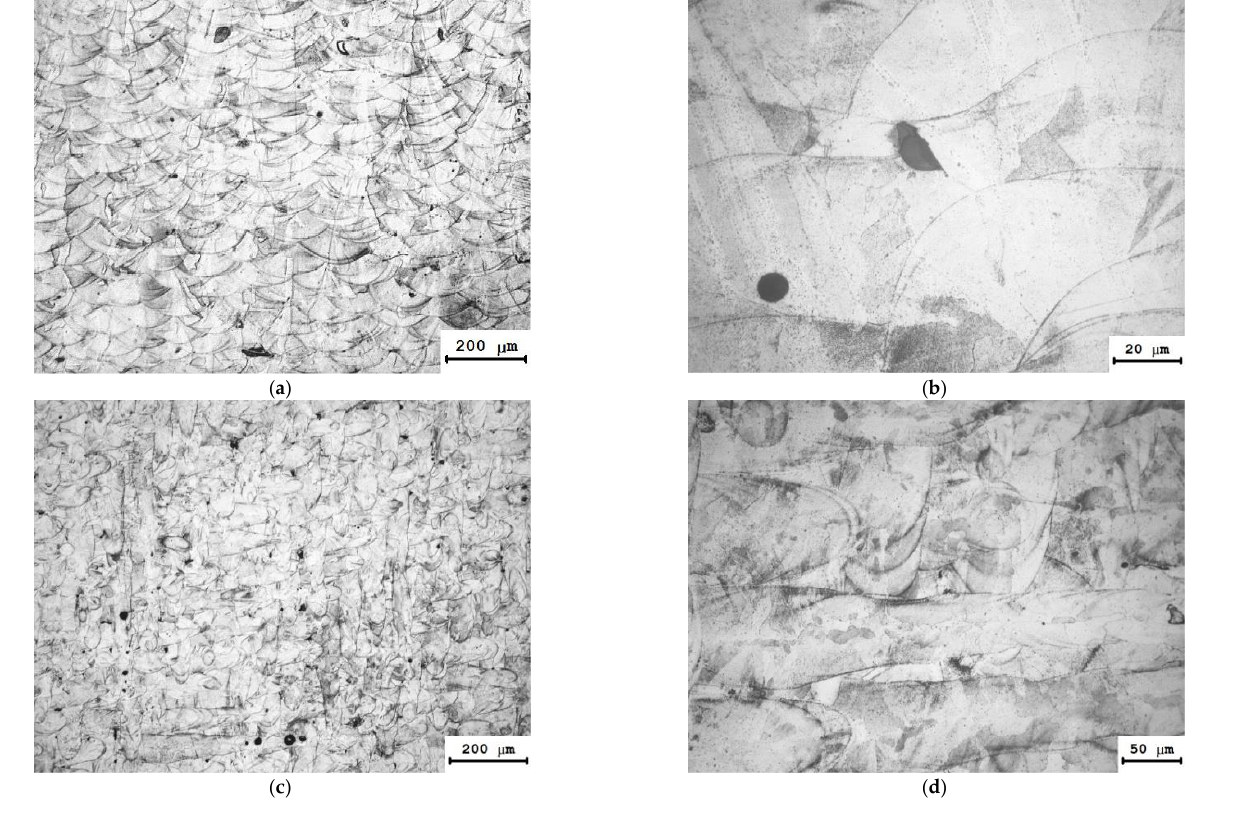
Figure 7. Microstructure of a steel 316L cylindrical specimen: ( a , b )—XZ plane; ( c , d )—XY plane.